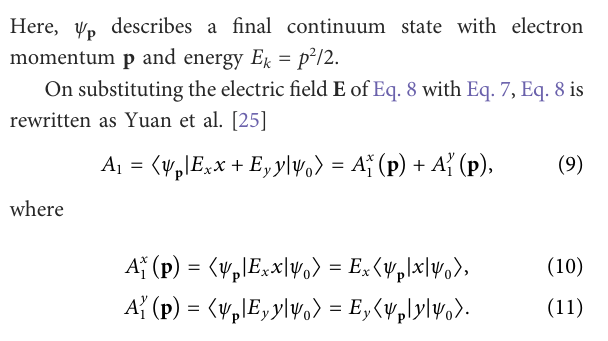
FIGURE 3 (Color online) Photoelectron momentum distribution of hydrogen atoms in the presence of laser pulse with τ 0 = 1.5 fs, carrier frequency Z ω 0 = 53.605 eV, and the peak intensities I 0 = 10 14 W/cm 2 . Graphs (A) and (B) reveal the momentum distributions from the linear polarized x - and y -direction, respectively. Graph (C) shows the result from a circularly polarized laser pulse, while (D) is the momentum distribution from the superposition of (A) and (B) two perpendicular linearly polarized pulses. Panel (E) is the photoelectron spectra of (A) the red solid line, (B) the blue dashed line, (C) the green dashed – dotted line, and (D) the black dotted